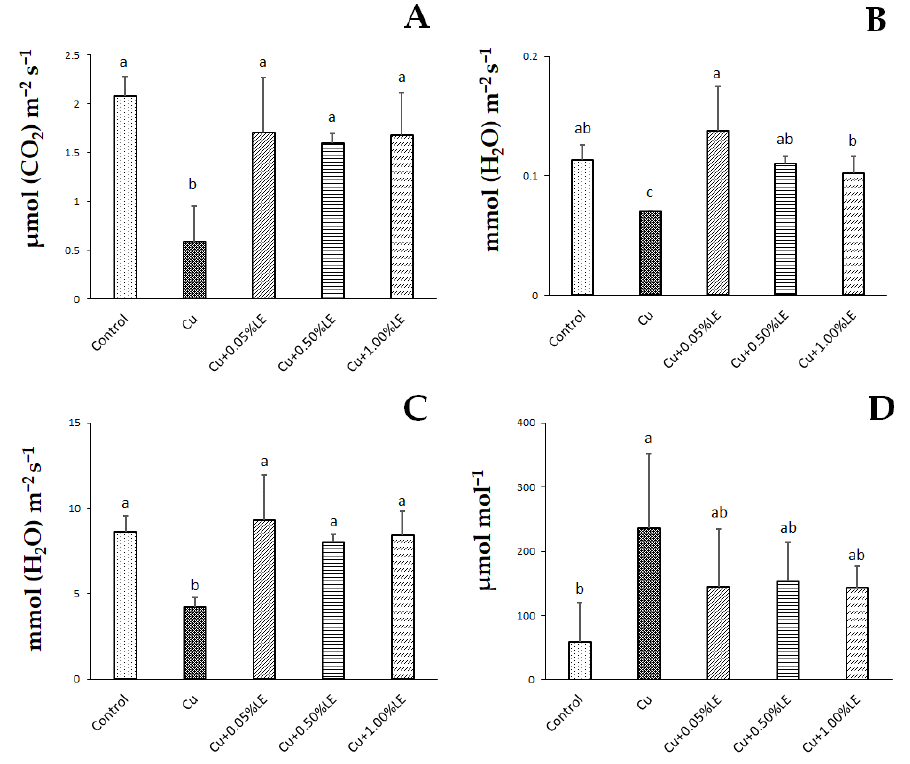
Figure 1. Means value of leaf net photosynthesis ( A ) ( µ mol (CO 2 ) m − 2 s − 1 ), leaf transpiration rate ( B ) (mmol (H 2 O) m − 2 s − 1 ), stomatal conductance ( C ) (mmol (H 2 O) m − 2 s − 1 ) and sub-stomatal CO 2 concentration ( D ) ( µ mol mol − 1 ) recorded in control maize, samples treated with Cu alone and in combination with 0.05%, 0.50% and 1.00% LE. Bars indicate standard deviations (SD). Values with different letters were significantly different ( p < 0.05), as indicated by the one-way ANOVA followed by Duncan’s new multiple range